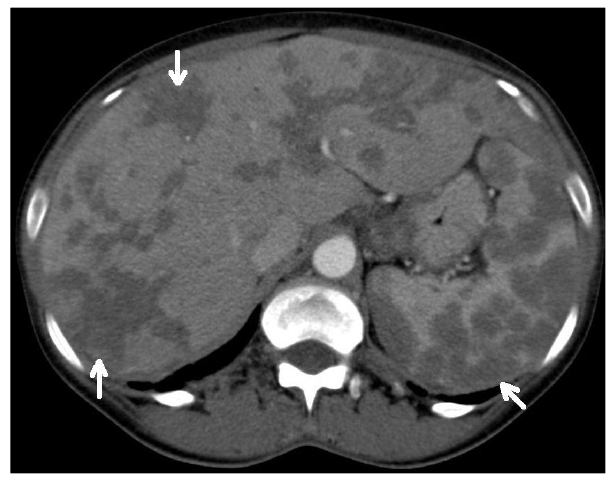
FIGURE 1 . CT abdomen with contrast. Arrows indicate irregular hypoattenuating masses in the liver and